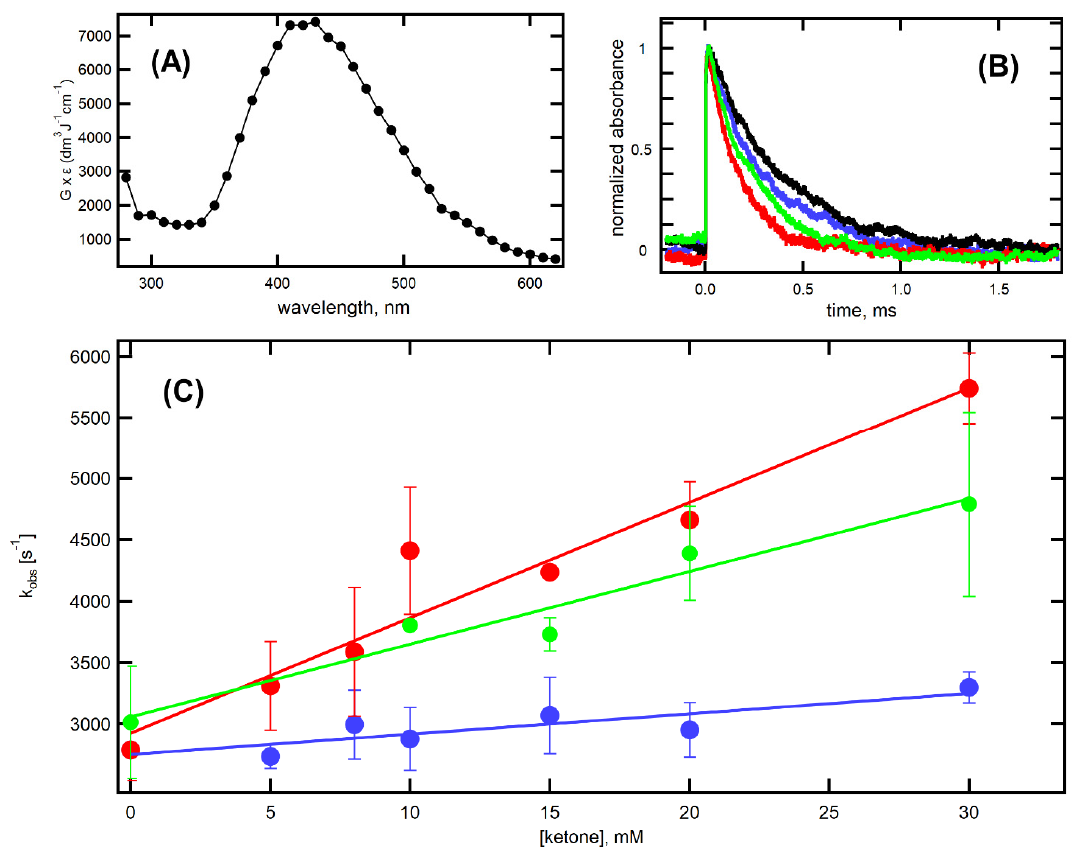
Figure 7. ( A ) Absorption spectrum of (CysSSCys) •− recorded 10 µ s after the electron pulse in N 2 O-saturated aqueous solutions at pH = 10.6 containing 100 mM of cysteine . ( B ) Normalized time profiles representing decay of transient absorption at λ = 420 nm, recorded after the electron pulse in N 2 O-saturated aqueous solutions at pH = 10.6, containing 100 mM of cysteine in the absence of ketones (black) and in the presence of 30 mM of 8 (blue), 16 (green) and 19 (red) . ( C ) Plots of the observed pseudo-first-order rate constants of the decay of the 420 nm absorption as a function of 8 ( • ), 16 ( • ) and 19 ( • ) concentration in N 2 O-saturated aqueous solutions at pH = 10.6, containing 100 mM of cysteine. Table 2. Rate constants (M − 1 s − 1 ) for the reactions of (CysSSCys) •− and HO • with the three cyclic